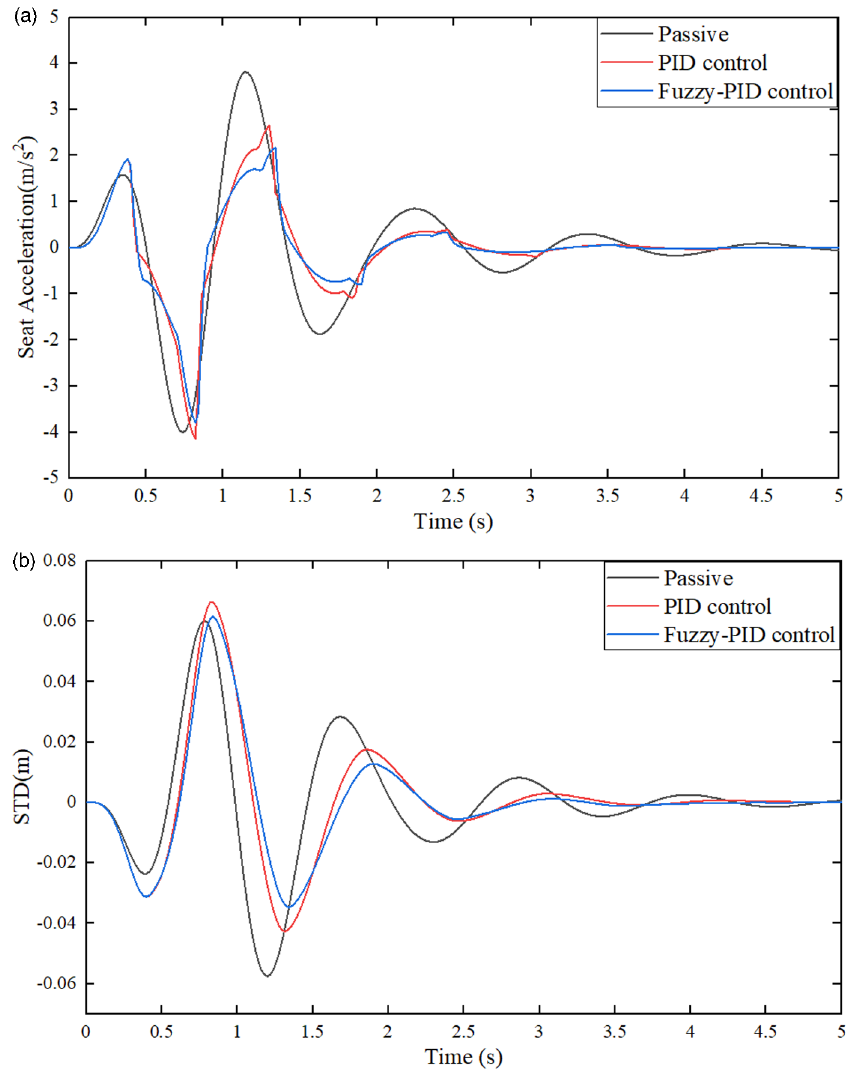
Fig. 12. Time domain characteristics of the seat suspension system under bump road pro fi le: (a) seat acceleration; (b) seat travel stroke.